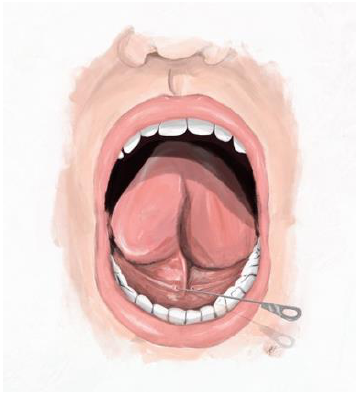
Figure 1. Insertion of the dilatation probe into the orifice of submandibular duct. The figure depicts the anatomy of the mouth floor, including two submandibular duct papillae. The dilatation probe is inserted into the right orifice of Wharton’s duct.